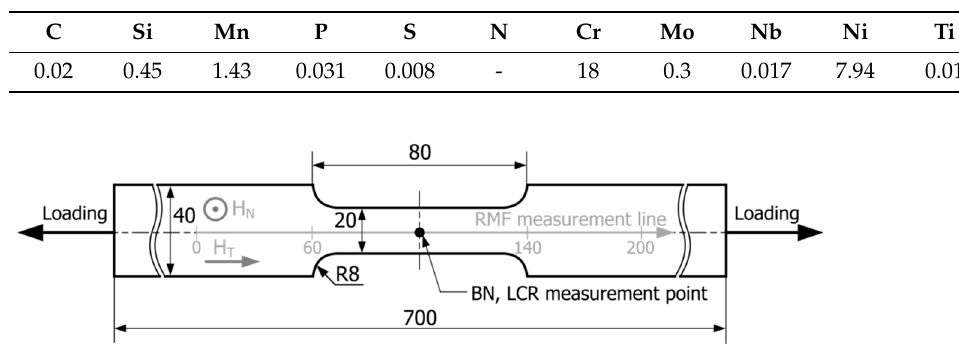
Table 1. Chemical composition of X2CrNi18-9 steel (% by mass).